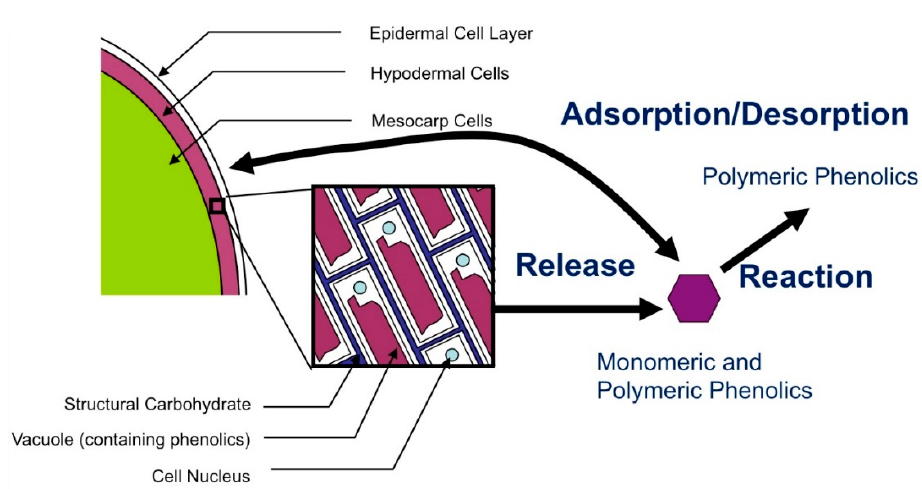
Figure 1. Diagram of processes involved in phenolic extraction. Phenolics are released from grape cells into solution, where they are free to either enter adsorption equilibrium onto the surface of the grape cell walls, or react (i.e., polymerization, degradation) in solution.